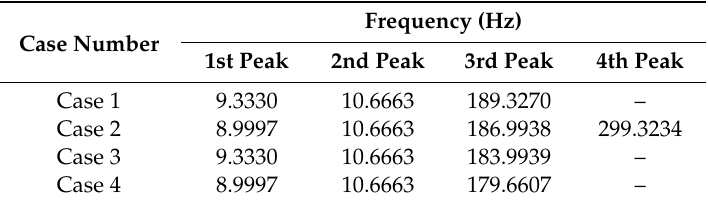
Table 1. Frequency values related to the essential peaks in FFT diagrams.